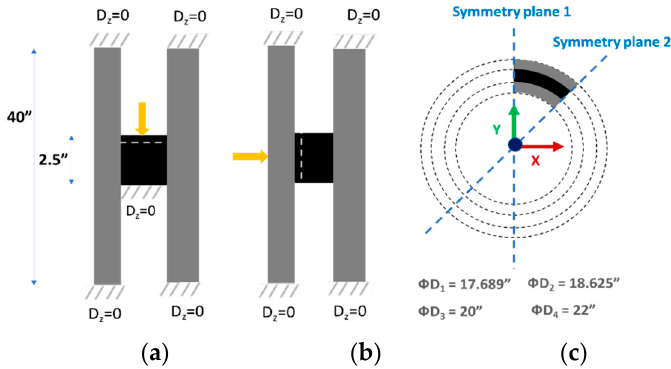
Figure 3. Two dimensional schematic of the Finite Element Analysis (FEA) models of ( a ) conventional and ( b ) expandable type hanger seal assembly, and ( c ) the top view.